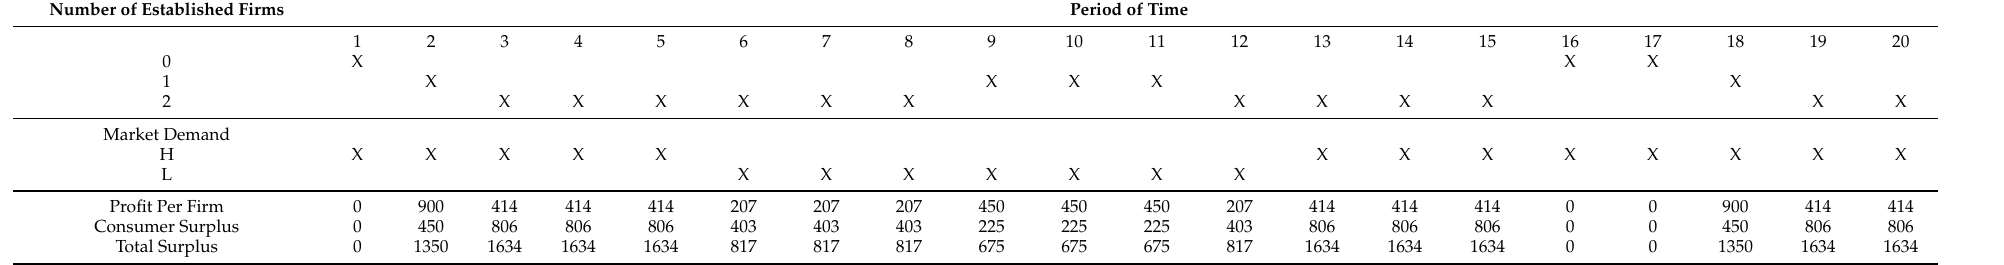
Table 7. Two active firms in the Cournot framework with the initial state of the system ( 0, H ) .